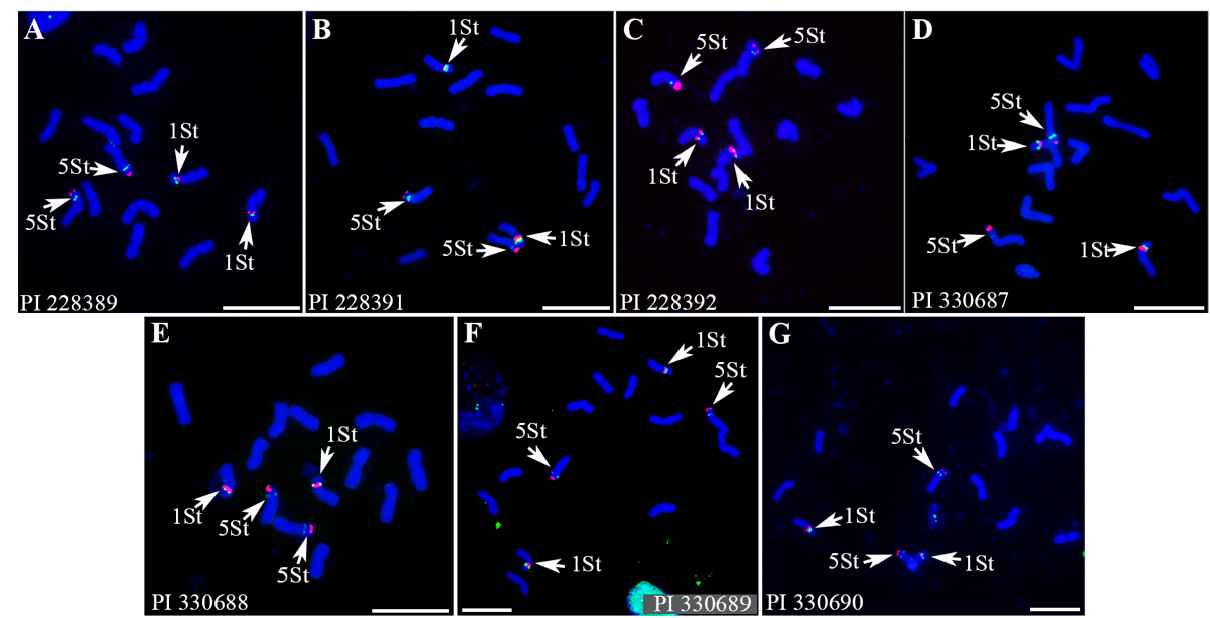
Figure 7. FISH on mitotic chromosomes of seven P. libanotica accessions with 45S rDNA (magenta) and 5S rDNA (green). ( A ) 45S rDNA (magenta) and 5S rDNA (green) in P. libanotica accession PI 228389. ( B ) 45S rDNA (magenta) and 5S rDNA (green) in P. libanotica accession PI 228391. ( C ) 45S rDNA (magenta) and 5S rDNA (green) in P. libanotica accession PI 228392. ( D ) 45S rDNA (magenta) and 5S rDNA (green) in P. libanotica accession PI 330687. ( E ) 45S rDNA (magenta) and 5S rDNA (green) in P. libanotica accession PI 330688. ( F ) 45S rDNA (magenta) and 5S rDNA (green) in P. libanotica accession PI 330689. ( G ) 45S rDNA (magenta) and 5S rDNA (green) in P. libanotica accession PI 330690. White arrows indicate chromosomes with secondary constriction regions. Scale bar equals 10 μ m.